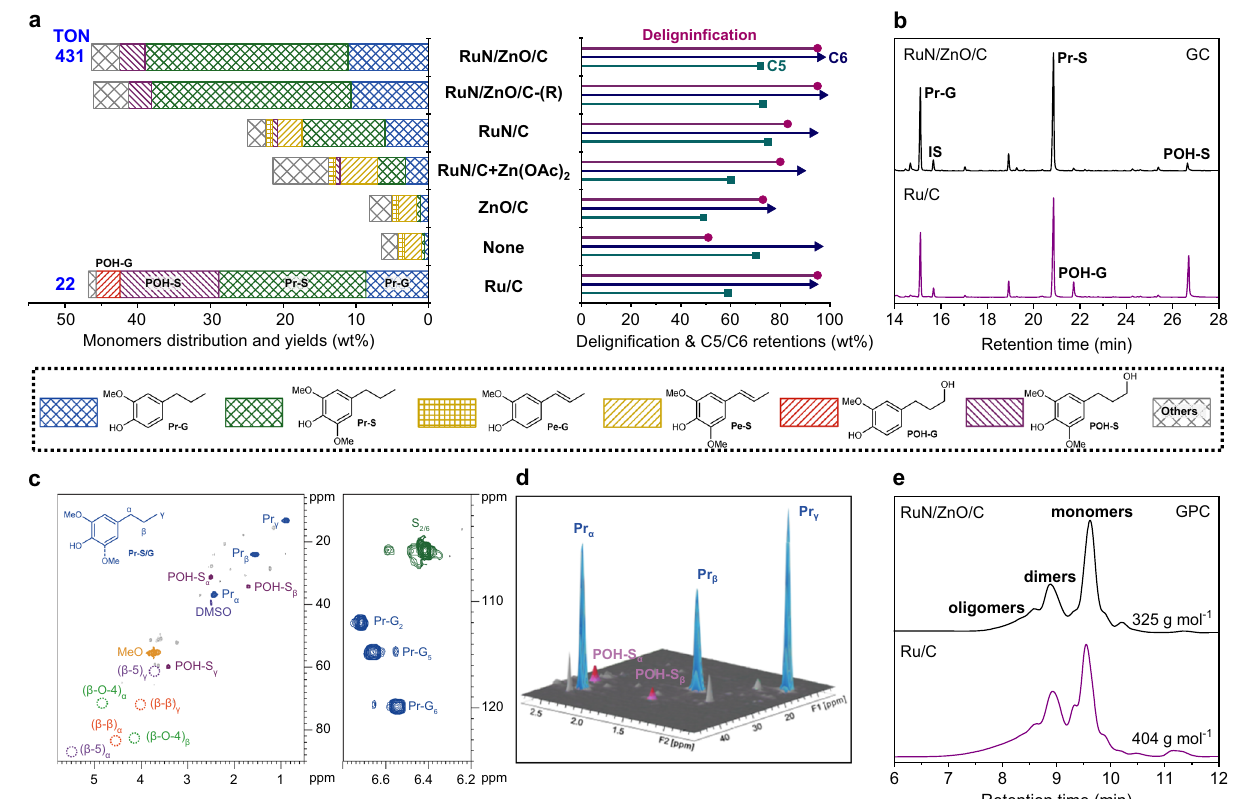
Fig.3|RCFofbirchoverdifferentcatalysts.a Comparisonsofphenolicmonomer yields, deligni fi cation degrees and C5/C6 retentions over different catalysts. b GC spectraof the lignin-derived monomers. c 2D HSQCNMR spectraof lignin-derived products from RCF of birch over RuN/ZnO/C (DMSO- d 6 ). d Three-dimensional version of the HSQC end-chain region. e GPC spectra of lignin-derived products.